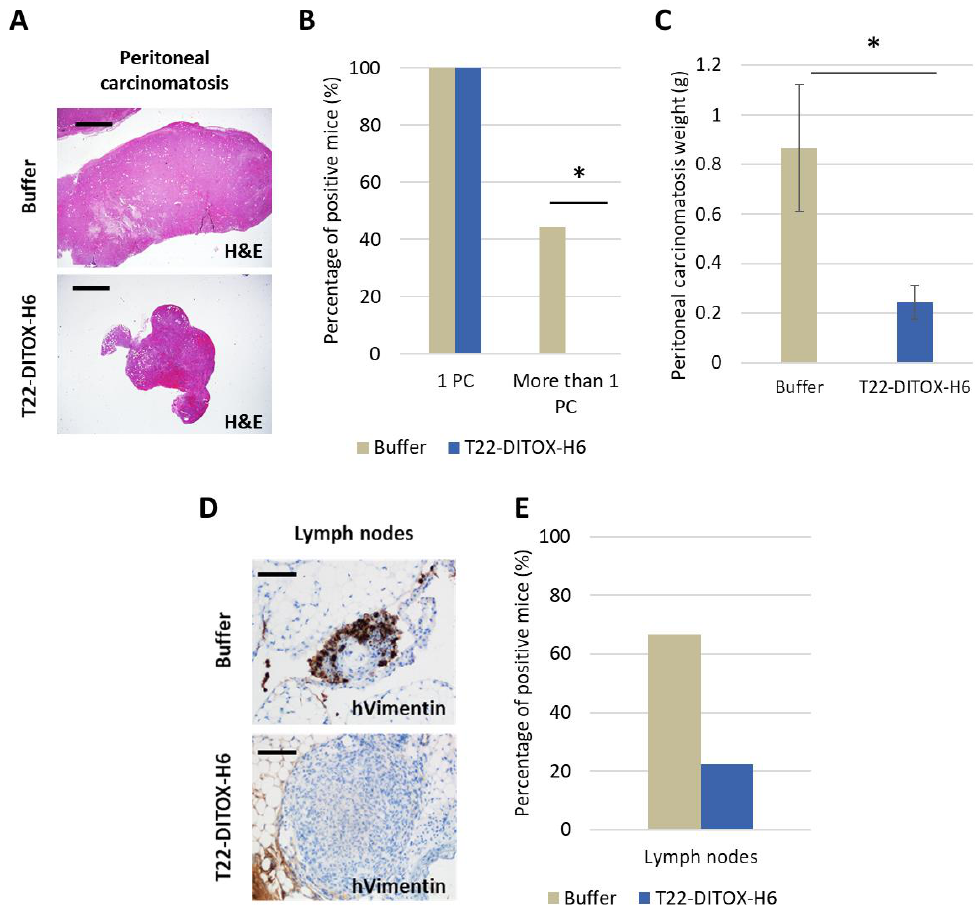
Figure 8. Antimetastatic effect in peritoneal and lymph node tissue after T22-DITOX-H6 repeated administration in the disseminated CXCR4 + AN3CA endometrial model. Mice were treated with either buffer or 5 ug T22-DITOX-H6 for a total of 14 doses. ( A ) Representative images of hematoxylin-eosin staining of peritoneal carcinomatosis in buffer or nanotoxin-treated mice (bar: 2 mm). ( B ) Percentage of control or nanotoxin-treated mice bearing one or more than one peritoneal carcinomatotic implant (* p = 0.041; Fisher test). ( C ) Comparison of the total weight of peritoneal carcinomatotic foci registered in control and nanotoxin-treated mice (* p = 0.036; Mann – Whitney U test). ( D ) Representative images of lymph node metastases in control and nanotoxin-treated mice by IHC detection of human vimentin (bar: 100 μm). ( E ) Percentage of control and nanotoxin-treated mice with positive lymph node metastases at endpoint.